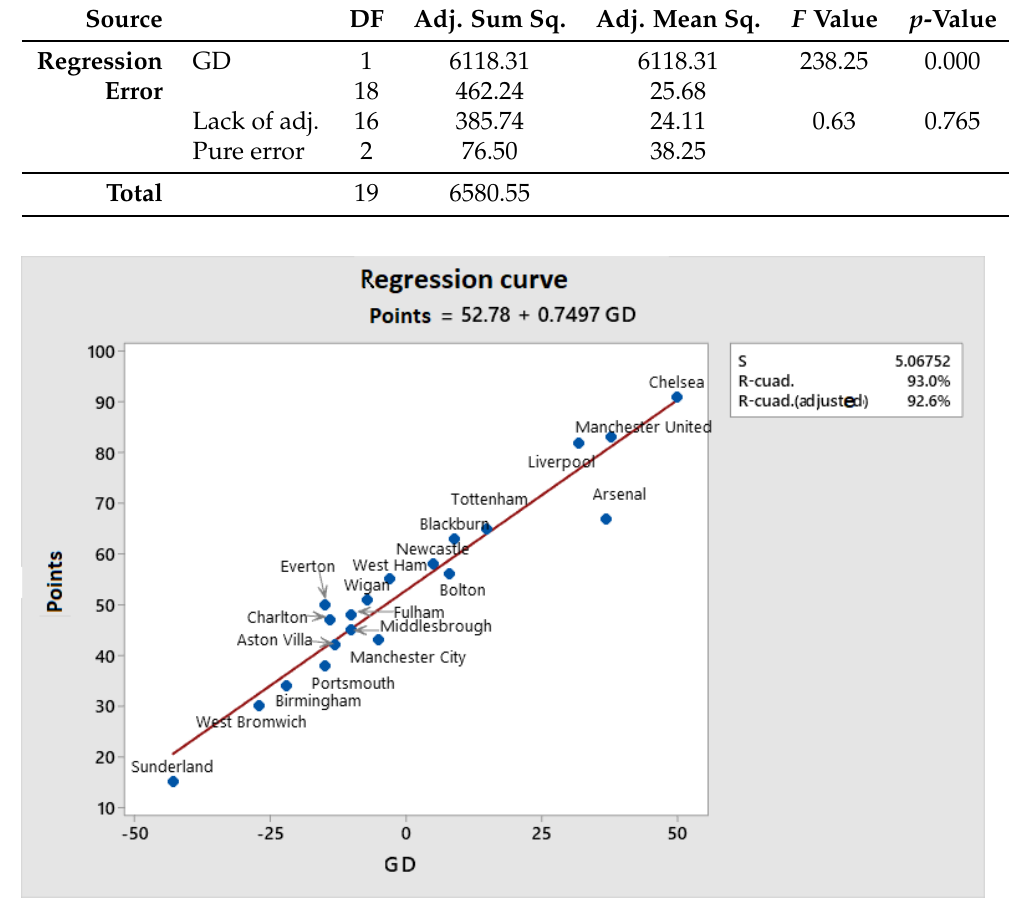
Figure 2. Regression curve between the obtained points and the goal difference at the ending of season